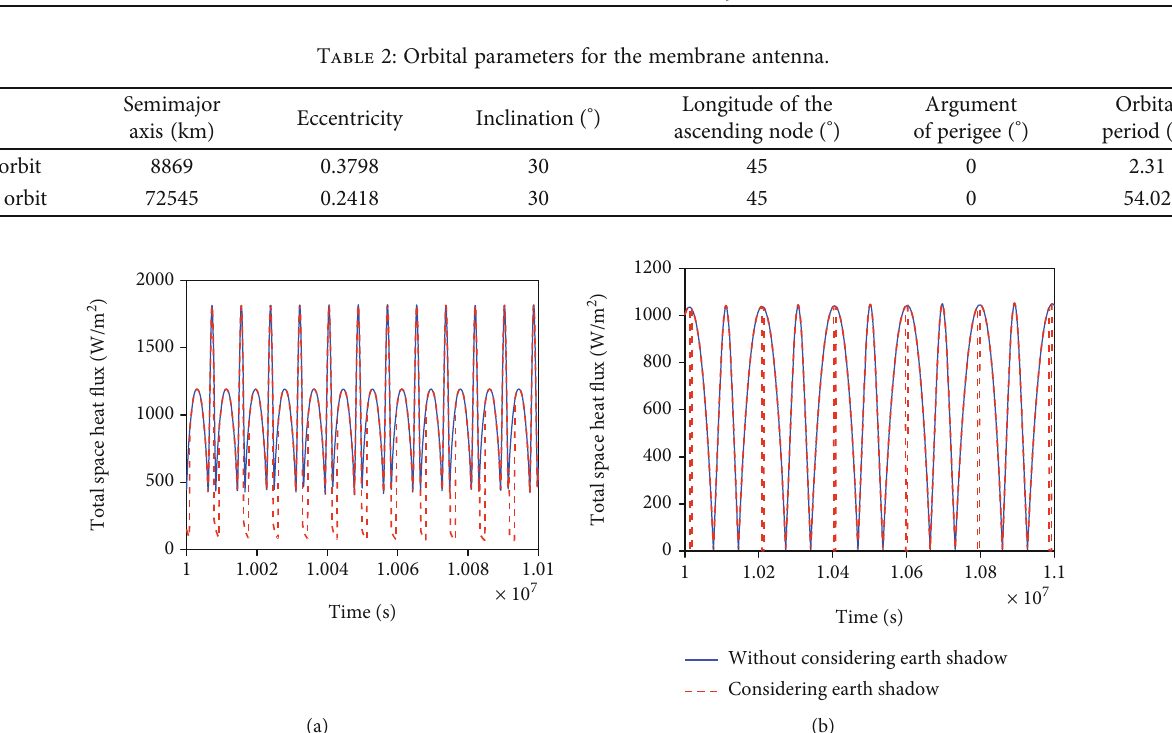
Figure 6: Space heat fl ux received by the membrane antenna structure: (a) low orbit; (b) high